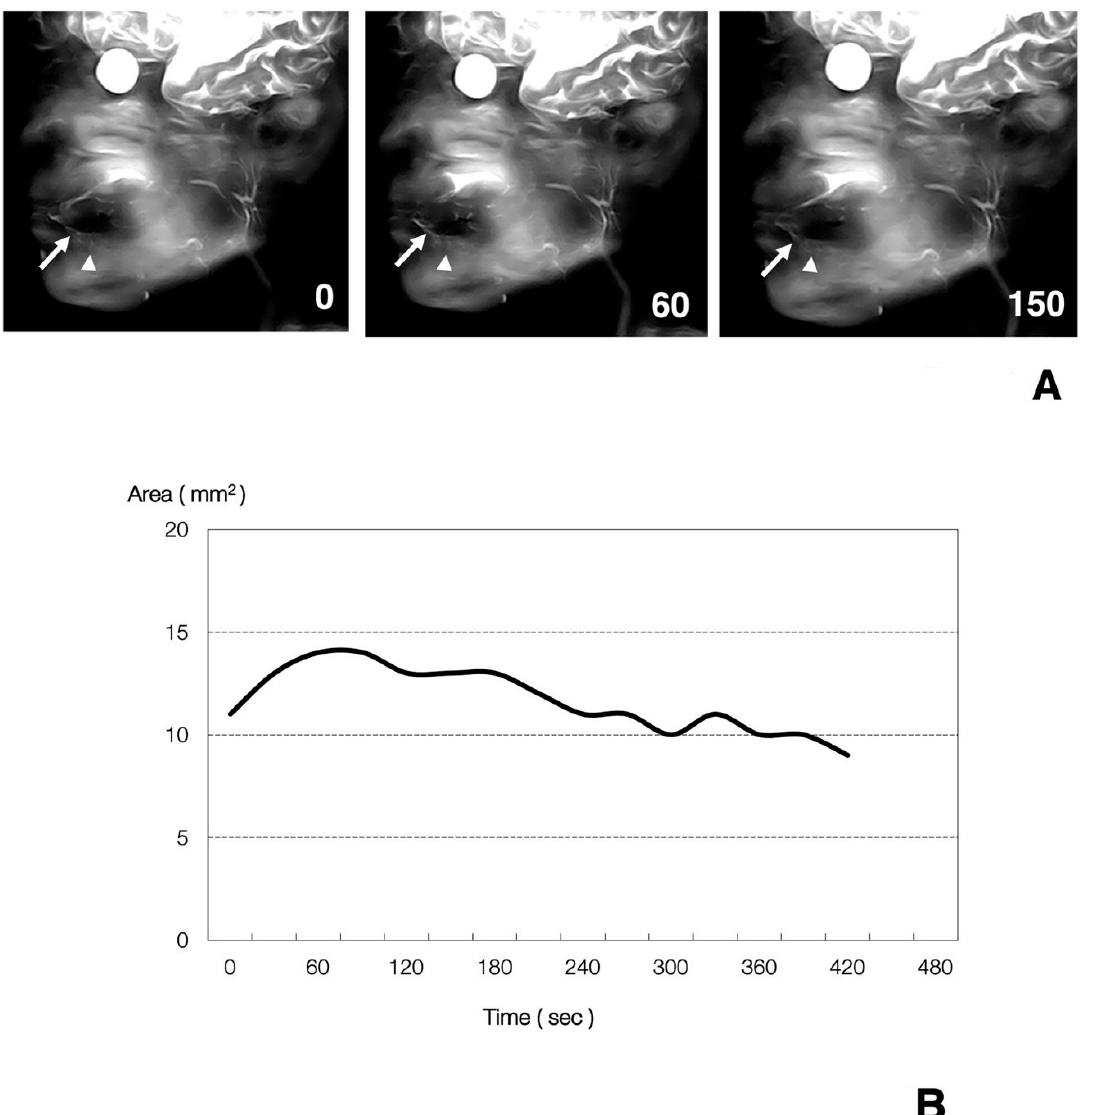
Figure 2. Dynamic MR sialographic images ( A ) and a graph ( B ) of sublingual gland ducts in a 26-year-old, healthy female volunteer. ( A ) The sublingual gland (arrowheads) and ducts (arrows) are gradually and slightly more clearly visualized after stimulation with citric acid for up to 60 s in a time- dependent manner. After 150 s, the many ducts became slightly clearer in a time-dependent fashion.